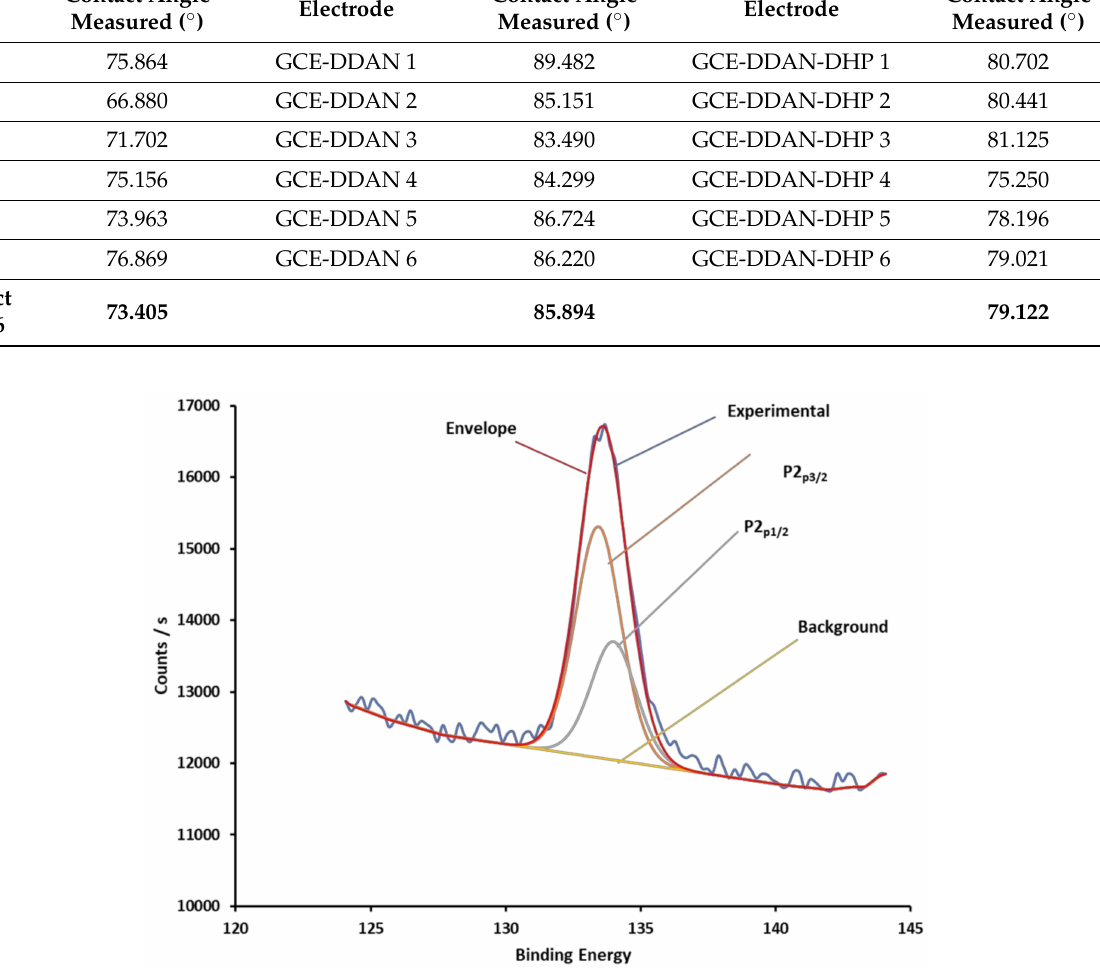
Figure 2. XPS spectra for the GCE-DDAN-DHP modification showing a clear distinct phos- phorus peak with an asymmetric peak envelop due to the overlapping P2 p3/2 and P2 p1/2 spin orbit